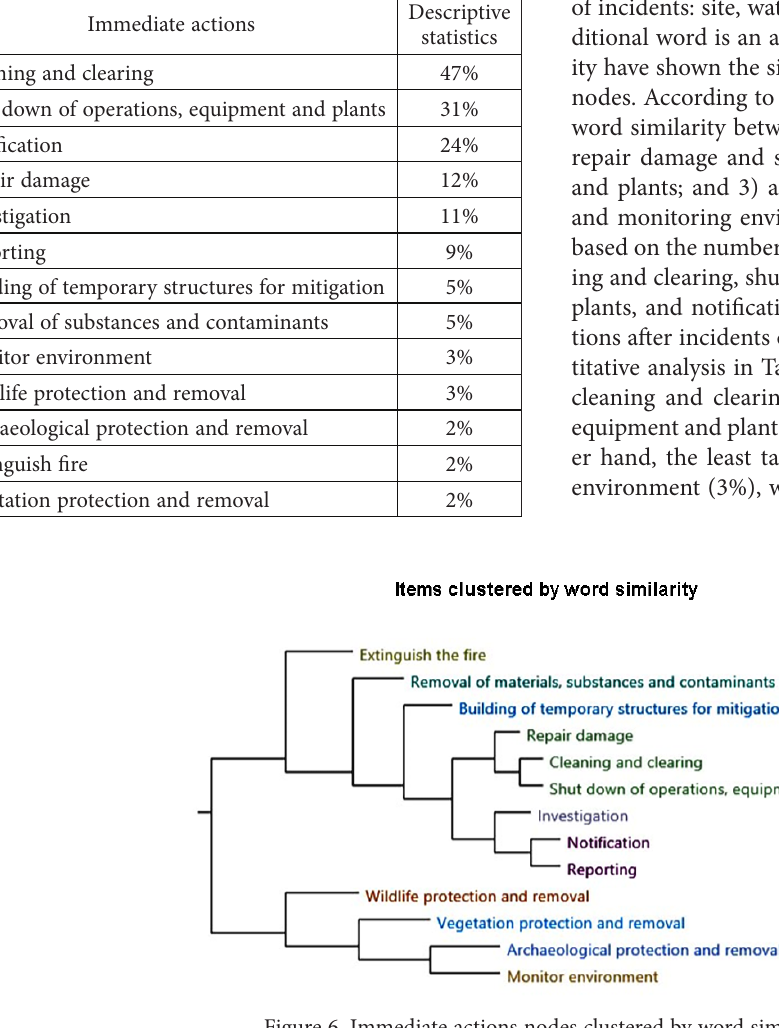
Figure 6. Immediate actions nodes clustered by word